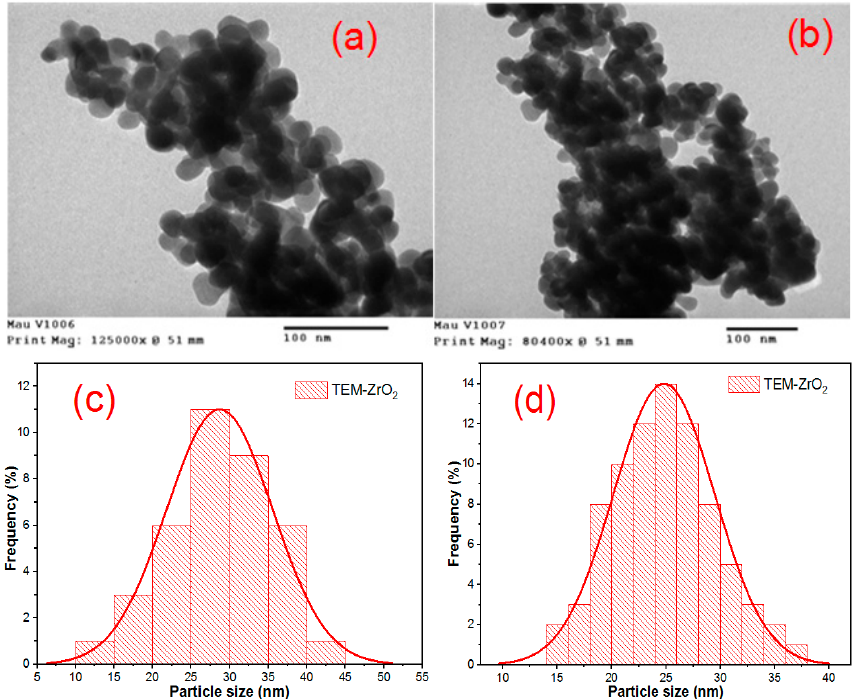
Figure 7. ( a , b ) TEM images and ( c , d ) particle size distribution of ZrO 2 nanoparticles after L.L.E by D2EHPA/p-xylenes. The energy-dispersive X-ray spectrum (Figure 8) and the X-ray fluorescence data (Figure 9) are recorded for the quantitative determination of the trace elements to evaluate the product purity.